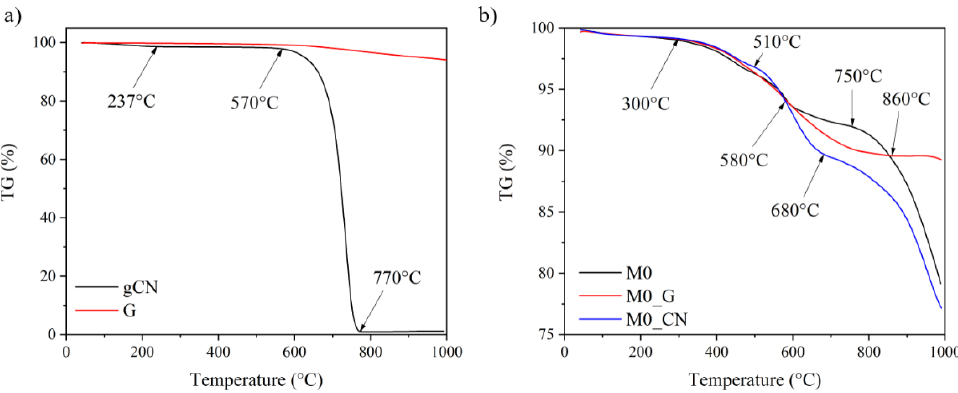
Figure 4. ( a ) TG curves for components G and gCN and ( b ) for friction mixtures M0, M0_G and M0_CN.